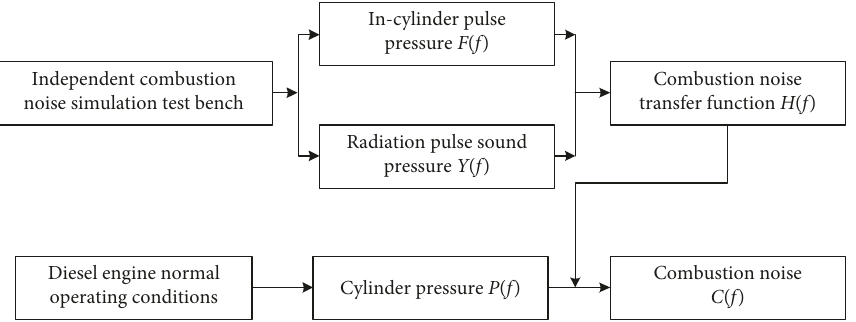
Figure 2: Calculation principle of combustion noise. Table 1: Main technical parameters of 4120SG diesel